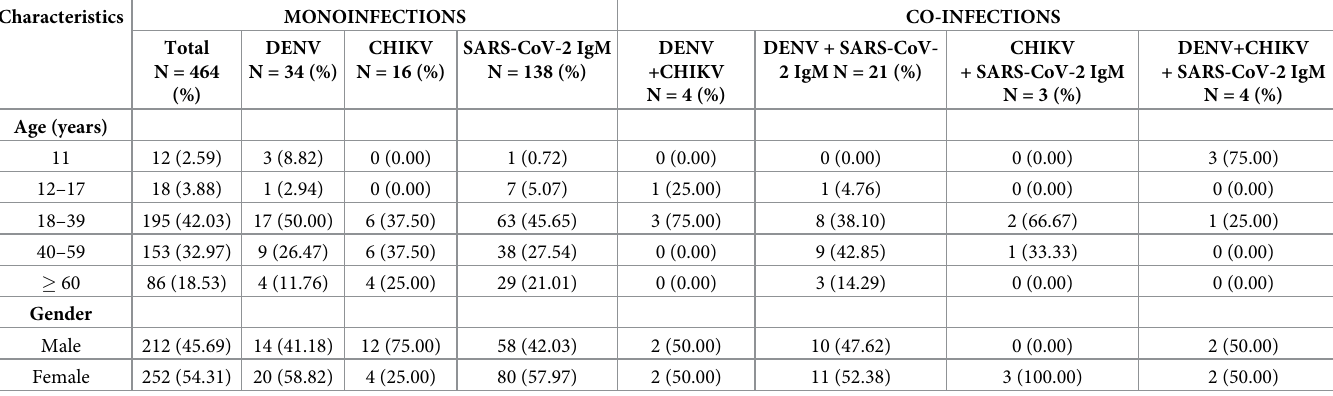
Table 1. Demographic characteristics of the patients according to the pattern of infection.